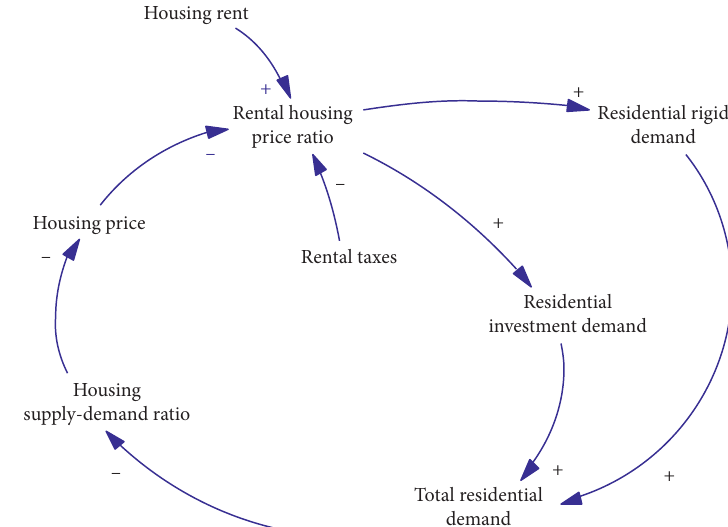
Figure 7: Causality diagram of residential leasing